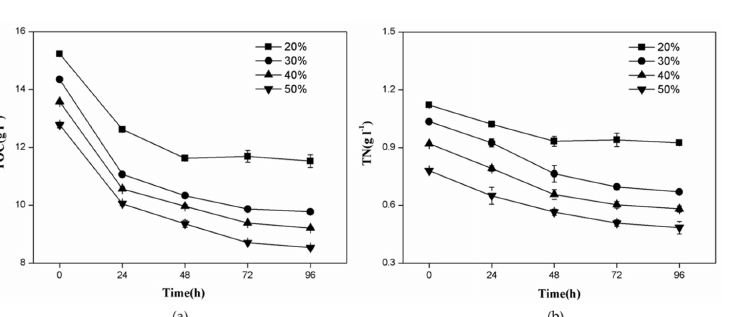
Fig. 4. Effects of the different inoculums of R. palustris on the removals of TOC (a) and TN (b) from landfill leachate.